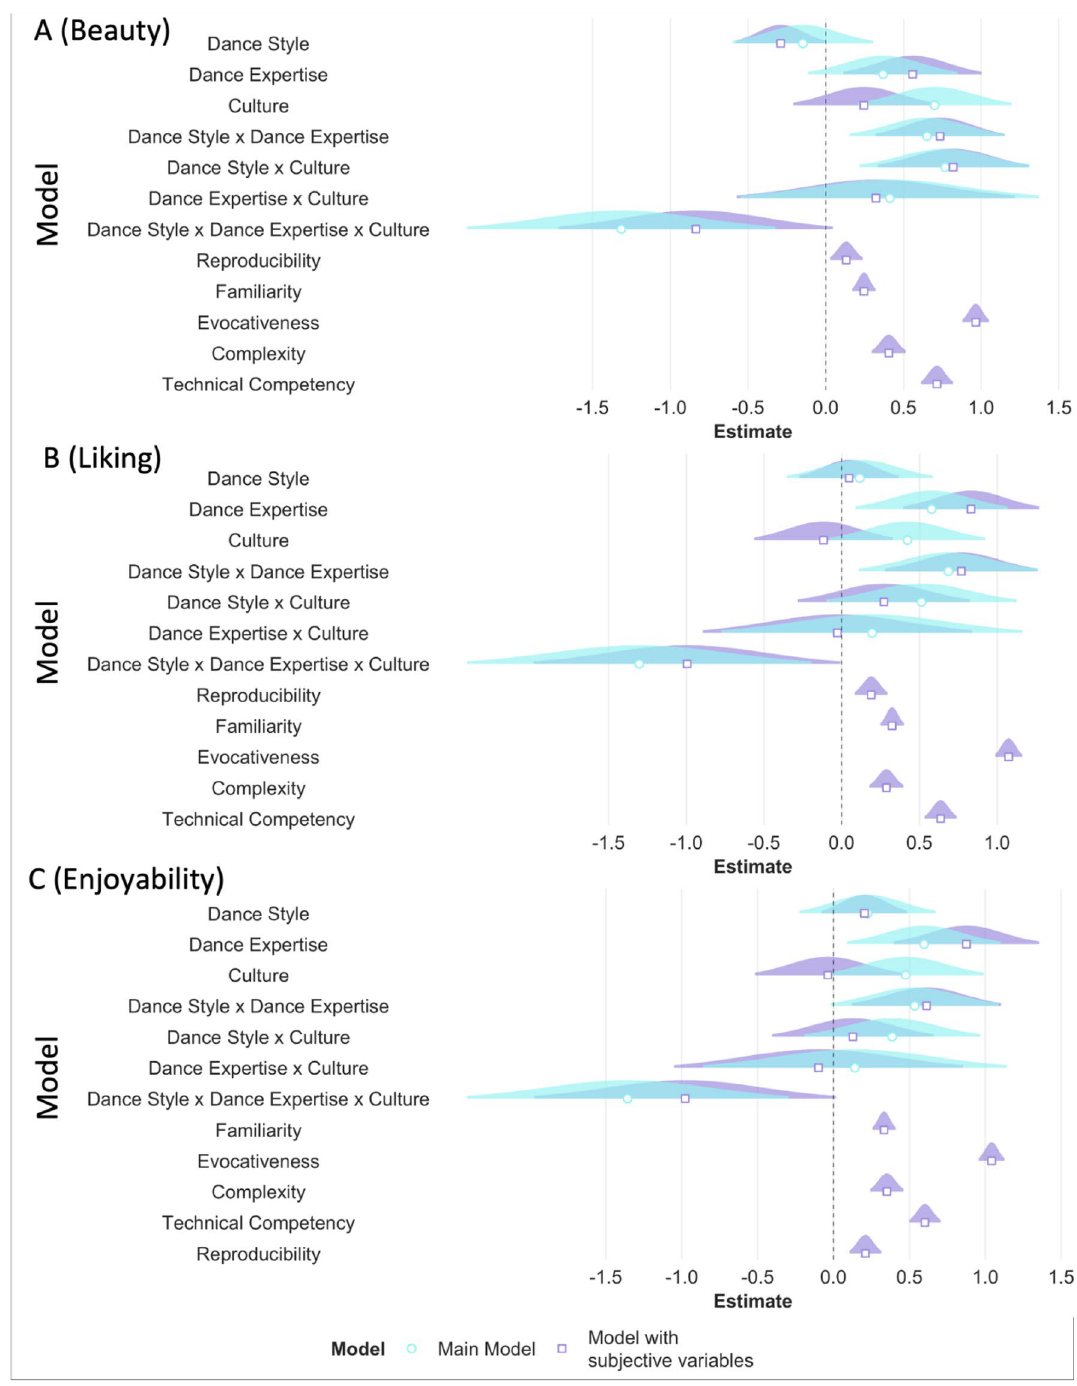
Figure 13. RQ2: The effect of Expertise, Culture, and Dance Style. For the outcome variables of beauty ( A ), liking ( B ), and enjoyability ( C ) beta estimates for the main model (in aqua blue) and the model with subjective variables (in purple) are plotted for each predictor variable along with their corresponding uncertainties (95% confidence interval width for a normal distribution for each estimate). Distributions are rescaled to match the height of each